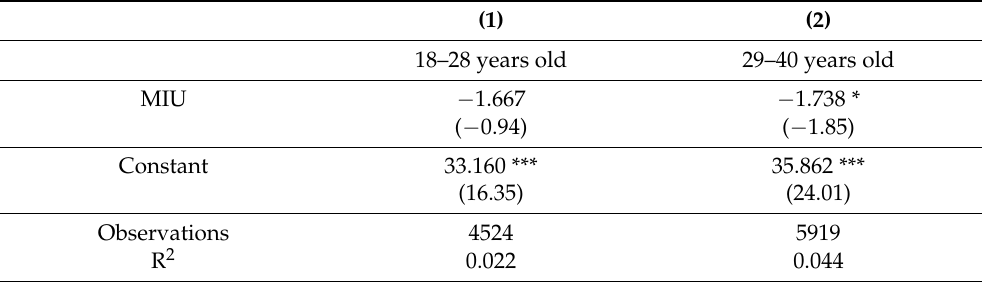
Table 7. Heterogeneous effects 1.